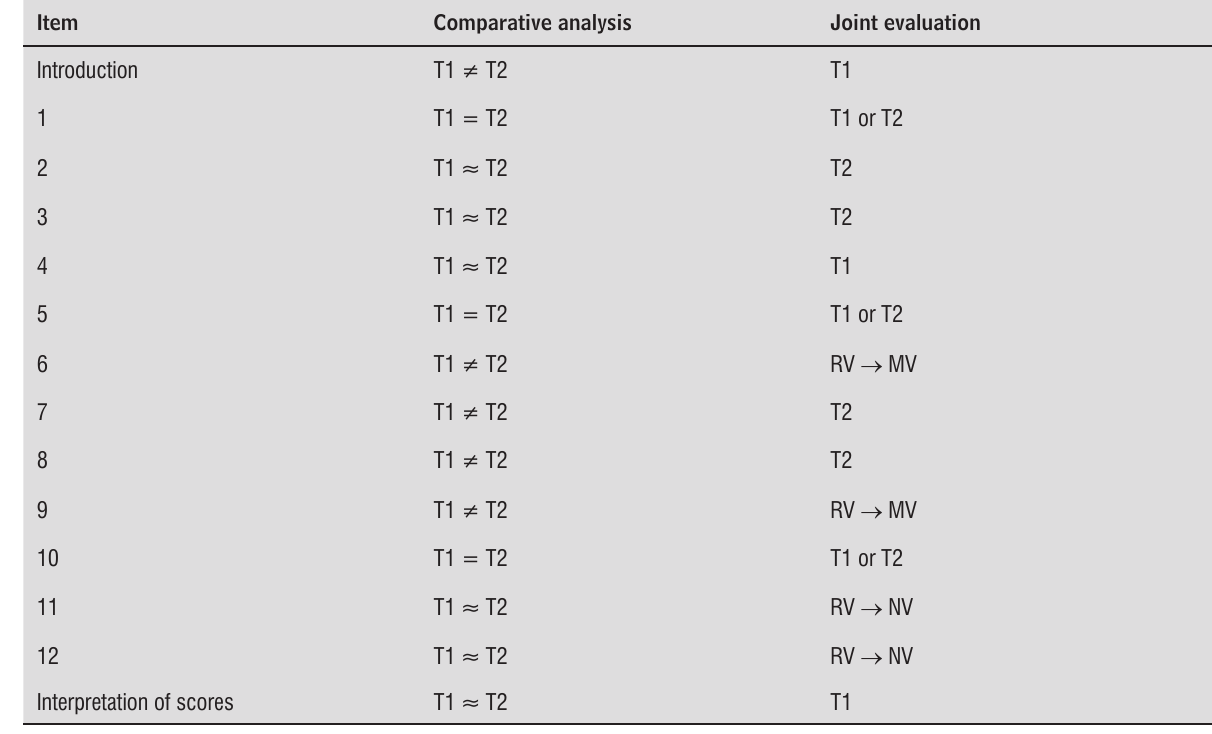
Table 2 - Summary of translation process of DASI